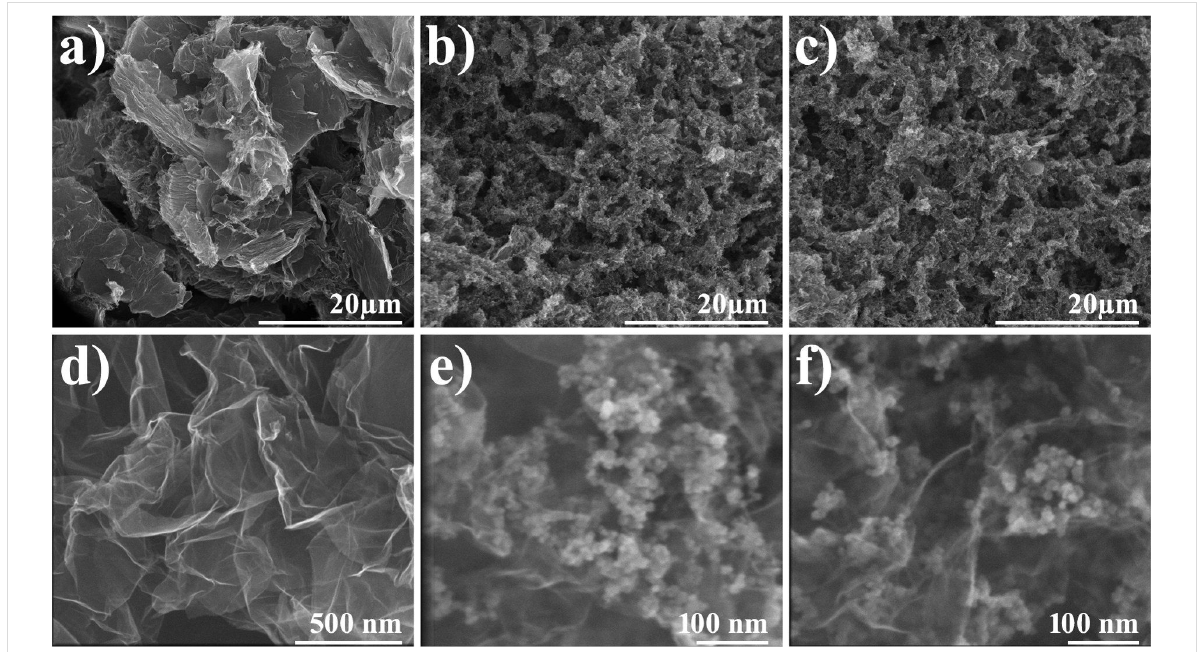
Figure 1: SEM micrographs of rGO (a,d), rGO-Fe 3 O 4 (b,e) and rGO-PDA@Fe 3 O 4 (c,f) aerogel structures.